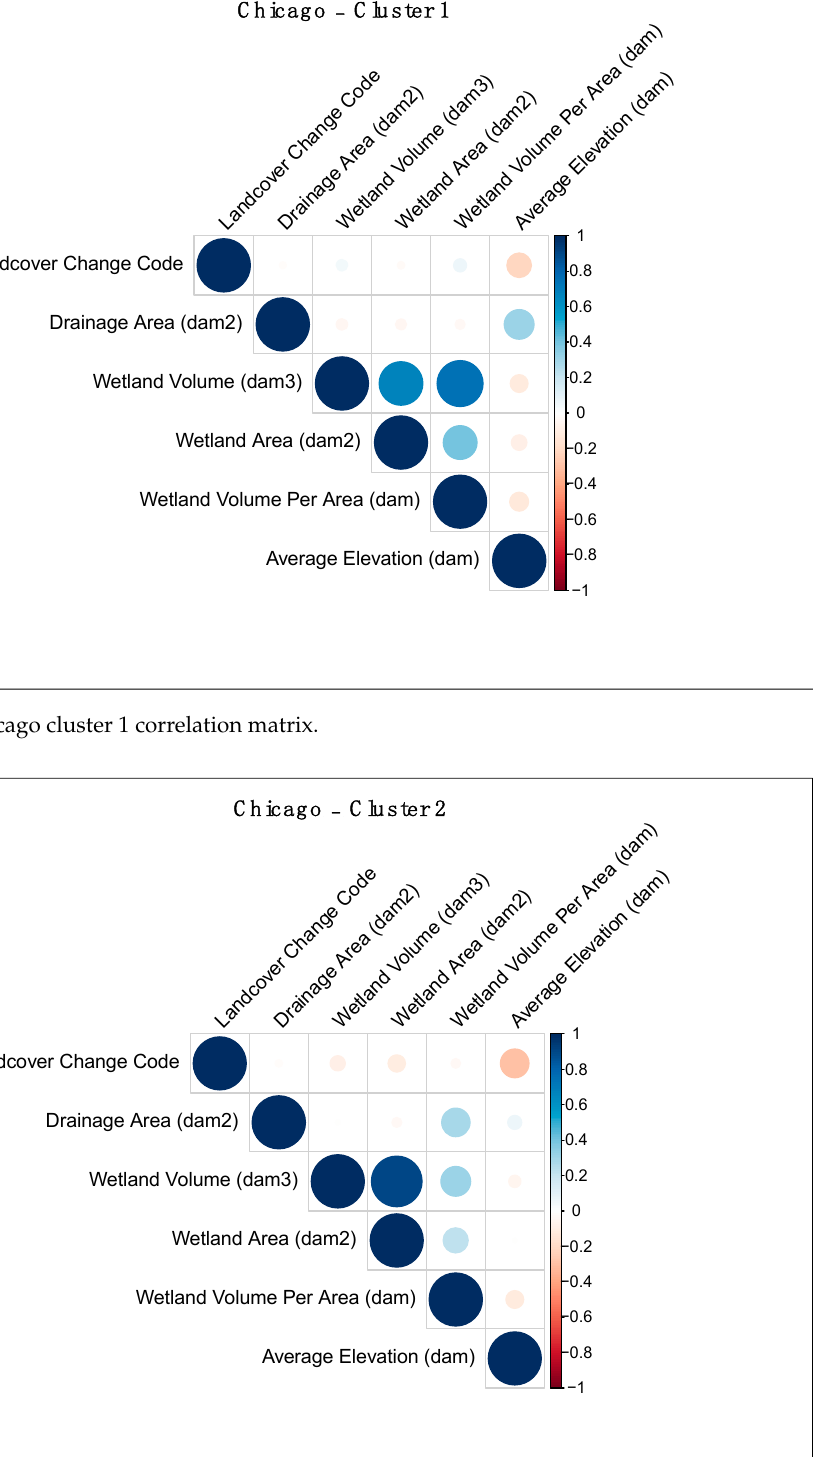
Figure 10. Chicago cluster 2 correlation matrix.